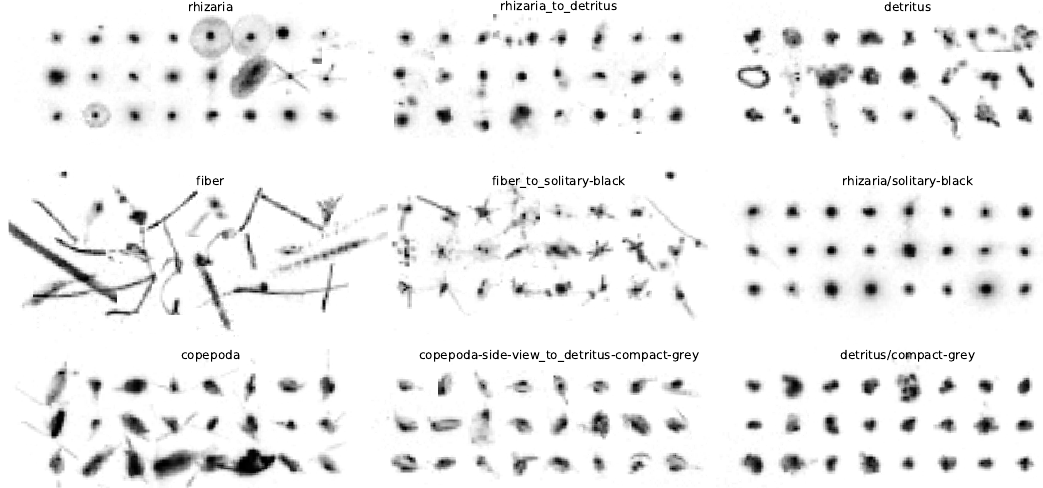
Figure 8. Four L 0 classes (denoted in Figure 7) and their corresponding L MC classes. These L 0 classes are highly diverse and can be split up into finer, very homogeneous groups using MorphoCluster.